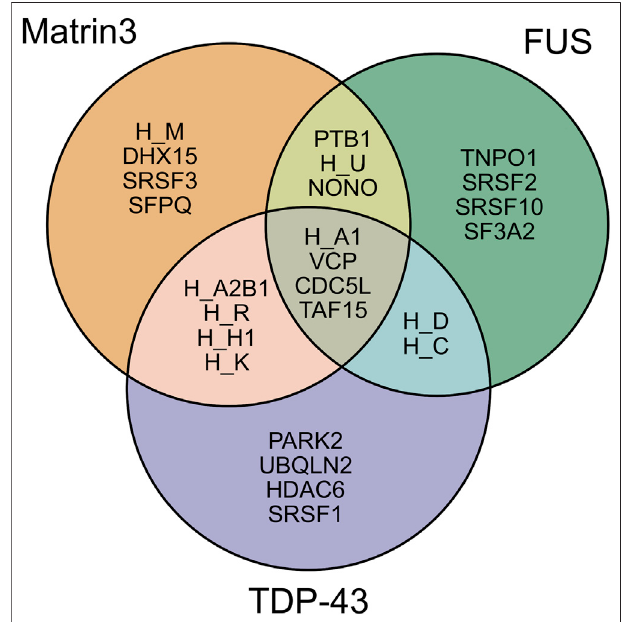
FIGURE 2 | Structural ensembles of Matrin3, FUS and TDP-43. (A) RNA-recognition motif (RRM) 1 from Matrin3 and the βαββαβ -structure is colored and indicated. (B) All RRMs in Matrin3, FUS, and TDP-43 are colored (blue: Matrin3-RRM1, yellow: Matrin3-RRM2, green: FUS, magenta: TDP-43-RRM1 and orange: TDP-43-RRM2) and superimposed. Signi fi cant homology is evident and FUS shows the greatest deviation within the ensemble (green). (C) C2H2 Zinc- fi nger motif (ZnF) 1 from Matrin3 and the ββα -structure is colored and indicated. Zinc-coordinating residues (two cysteines and two histidines) are indicated as sticks. (D) The disordered RanBP2-type ZnF found in FUS is shown. Zinc-coordinating residues (four cysteines) are indicated as sticks. (E) Both ZnF motifs in Matrin3 are colored (blue: ZnF1 and yellow: ZnF2) and superimposed, signi fi cant homology is evident. All structures are based on AlphaFold2 (Jumper et al., 2021) predictions.